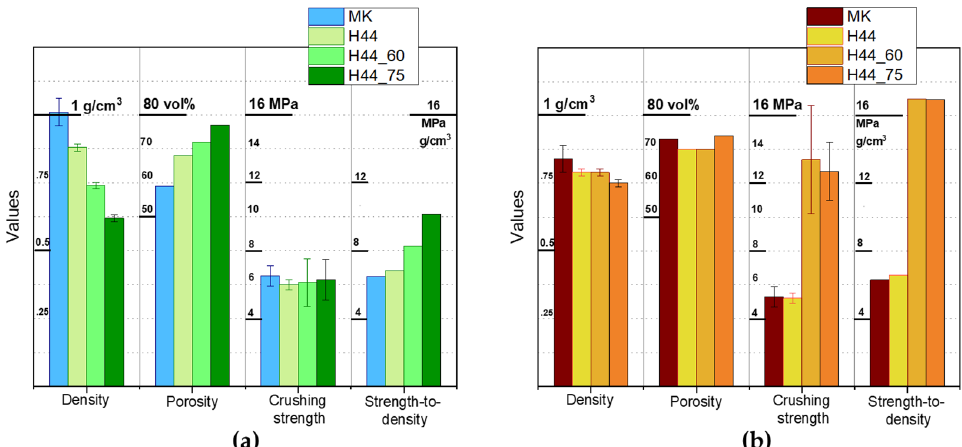
Figure 5. Overview of the properties of polymer-derived Biosilicate ® -like scaffolds: ( a ) fired in air; ( b ) fired in N 2. Each data point was obtained by testing at least eight specimens per sample.